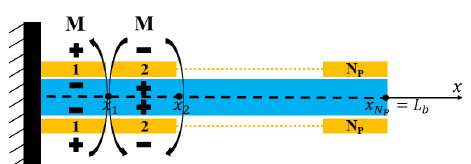
Figure 2. Actions of the piezoelectric plate on the